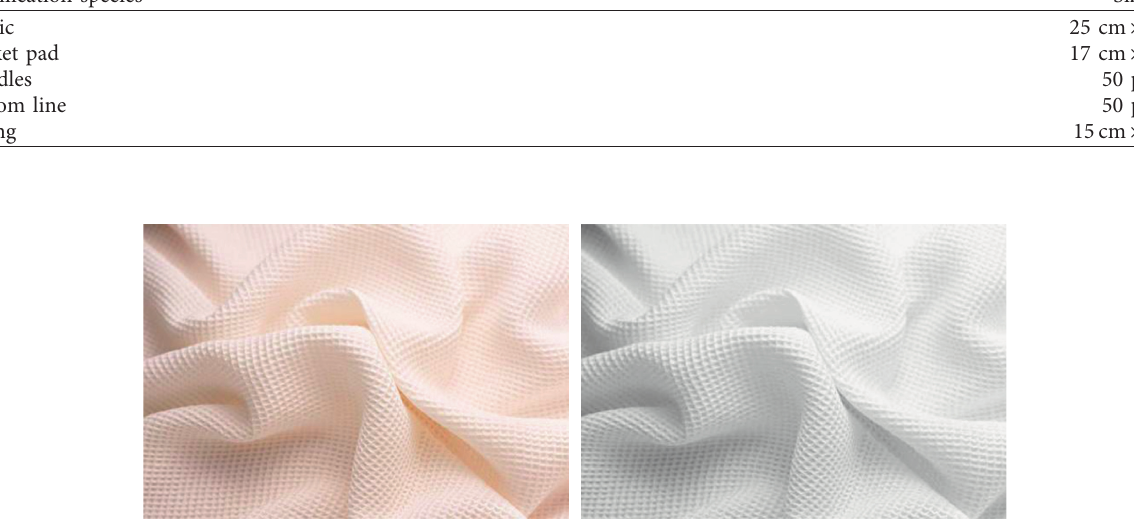
Figure 3: The gray-scale processing effect of MATLAB on the fabric. Table 3: Key action frame information.